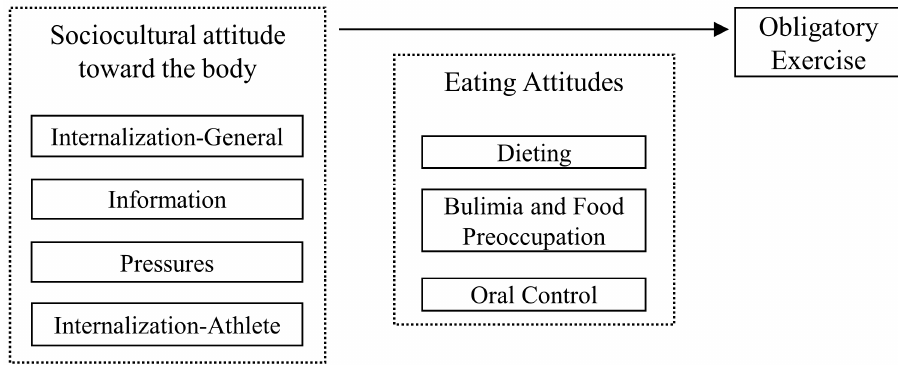
Figure 1. Theoretical model of the research variables (own elaboration).